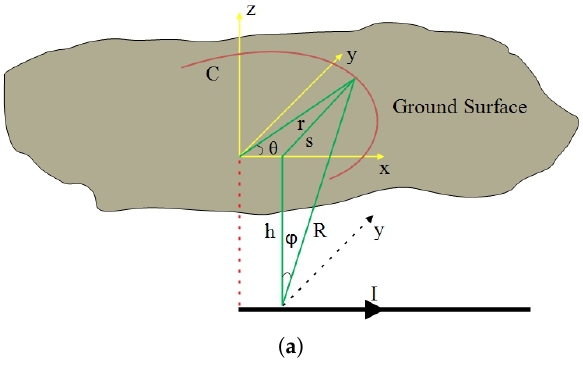
(cid:48) (cid:48)(cid:48)(cid:48) and amplitude of B z z